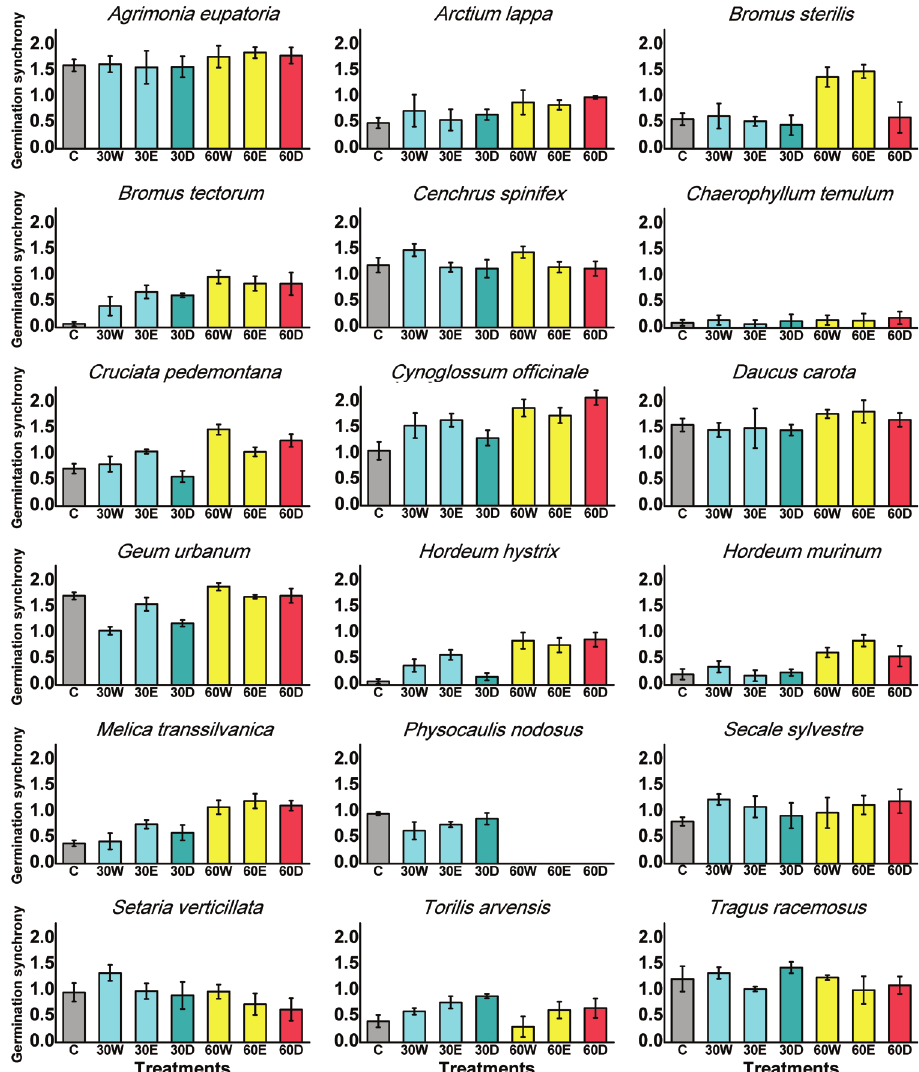
Figure 2. Germination synchrony, expressed as the Shannon diversity of the number of seedlings ger- minated in certain observation dates (mean ± SE) in the control and in the six washing treatments (5 replicates of 25 seeds were sown per species and treatment). Notations: grey column, C – control; blue columns: gentle washing at 30 °C (30W – washing with water at 30 °C, 30E – washing with eco-friendly soap nut at 30 °C and 30D – washing with detergent at 30 °C); yellow and orange columns – intense washing at 60 °C (60W – washing with water at 60 °C, 60E – washing with eco-friendly soap nut at 60 °C and 60D – washing with detergent at 60